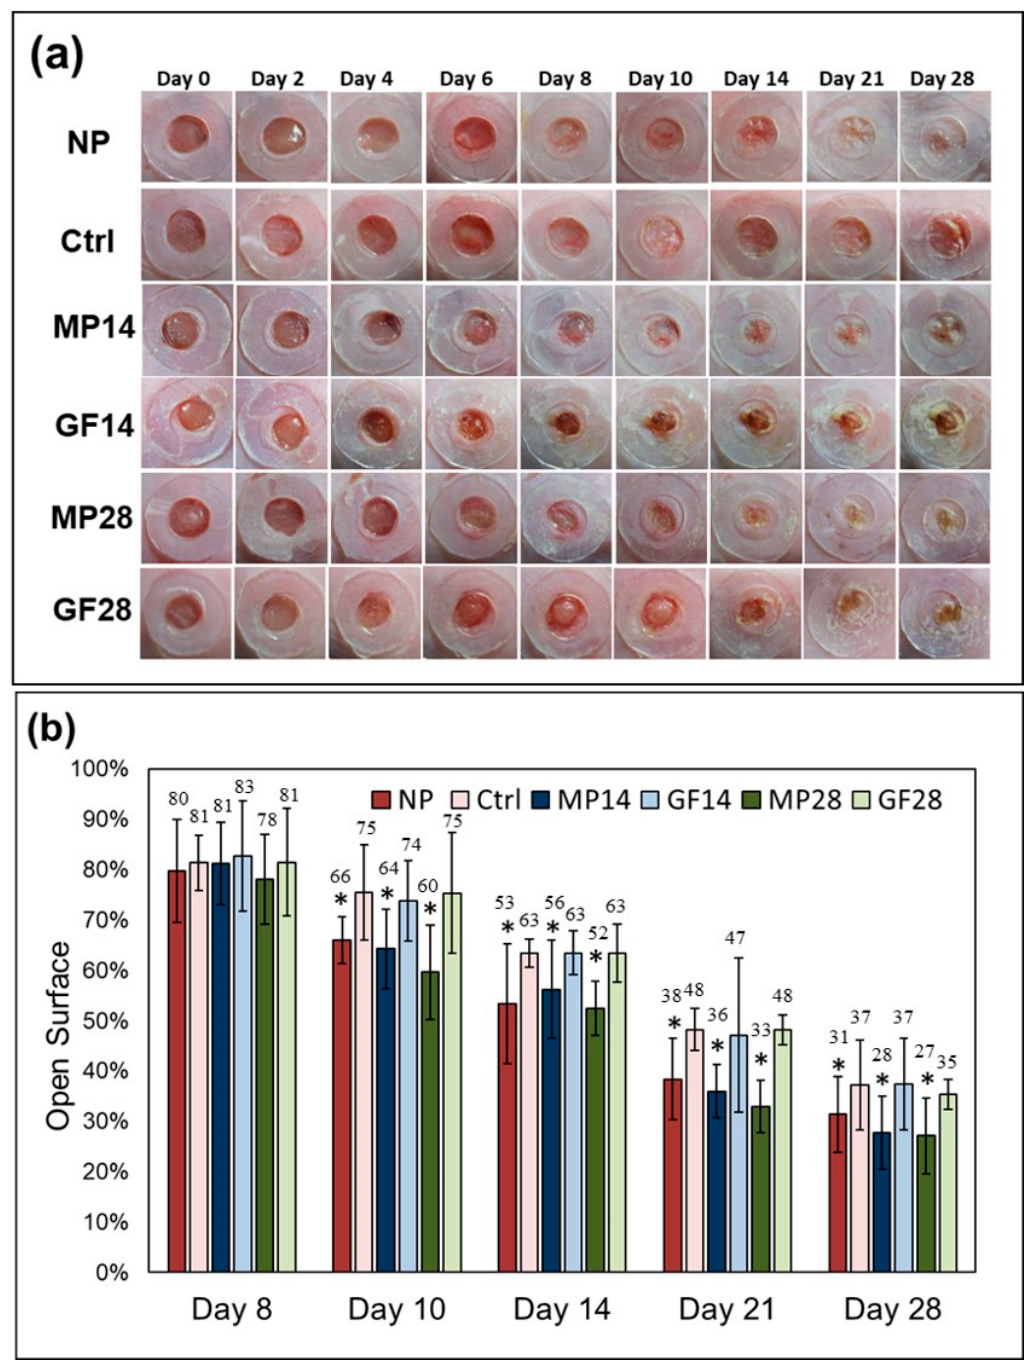
Figure 1. MP treatment promoted closure of the wound bed in the NP, control, MP14, GF14, MP28, and GF28 groups: ( a ) The splinted excisional wound in mice created on day 0 and measured on days 2, 4, 6, 8, 10, 14, 21, and 28 with representative photographs of the groups. ( b ) Measurements of open surface in mice conducted on days 8, 10, 14, 21, and 28. The values indicate the percentages of open surfaces in the groups. The values presented are the means ± SDs ( n = 9), with * p < 0.05 compared with the control group.